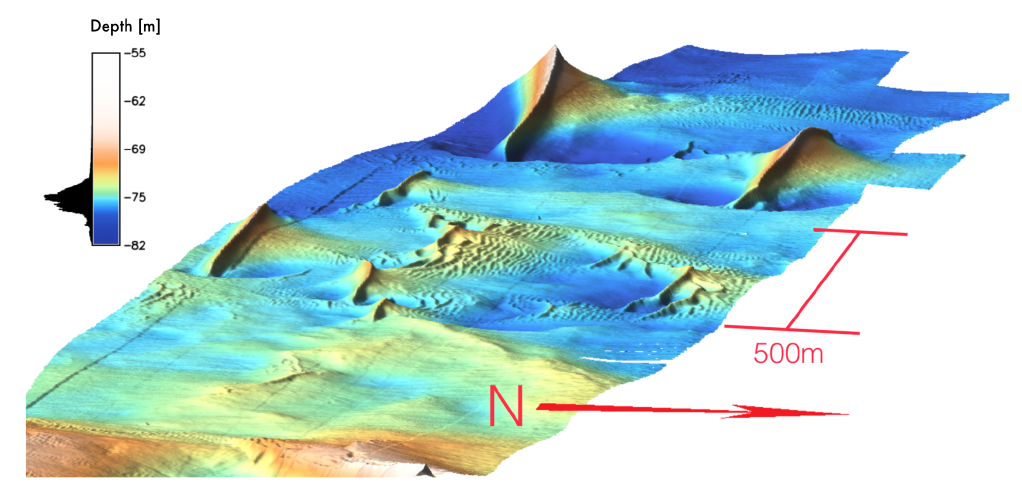
Figure 2. Details of the morphology of the study area (elevation exaggeration 3 ×